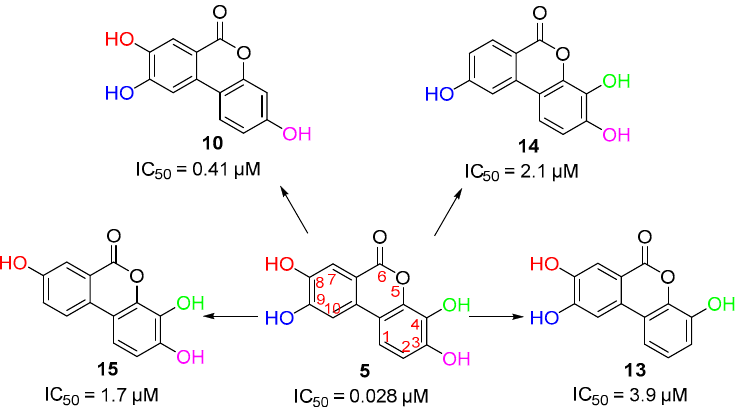
Figure 4. Urolithin C positional isomers and corresponding IC 50 vs. PKL.